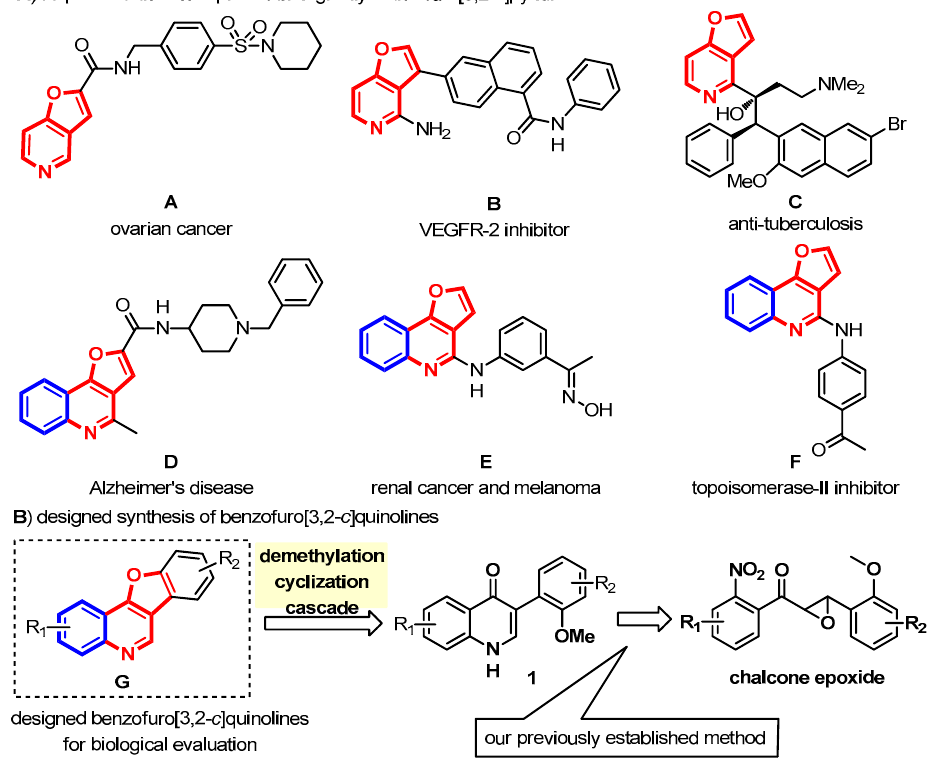
Figure 1. ( a ) Representative biologically active heterocycles bearing a furo[3,2- c ]pyridine skeleton and ( b ) the proposed synthesis method for tetracyclic benzofuro[3,2- c ]quinolines. ( b ) the proposed synthesis method for tetracyclic benzofuro[3,2- c